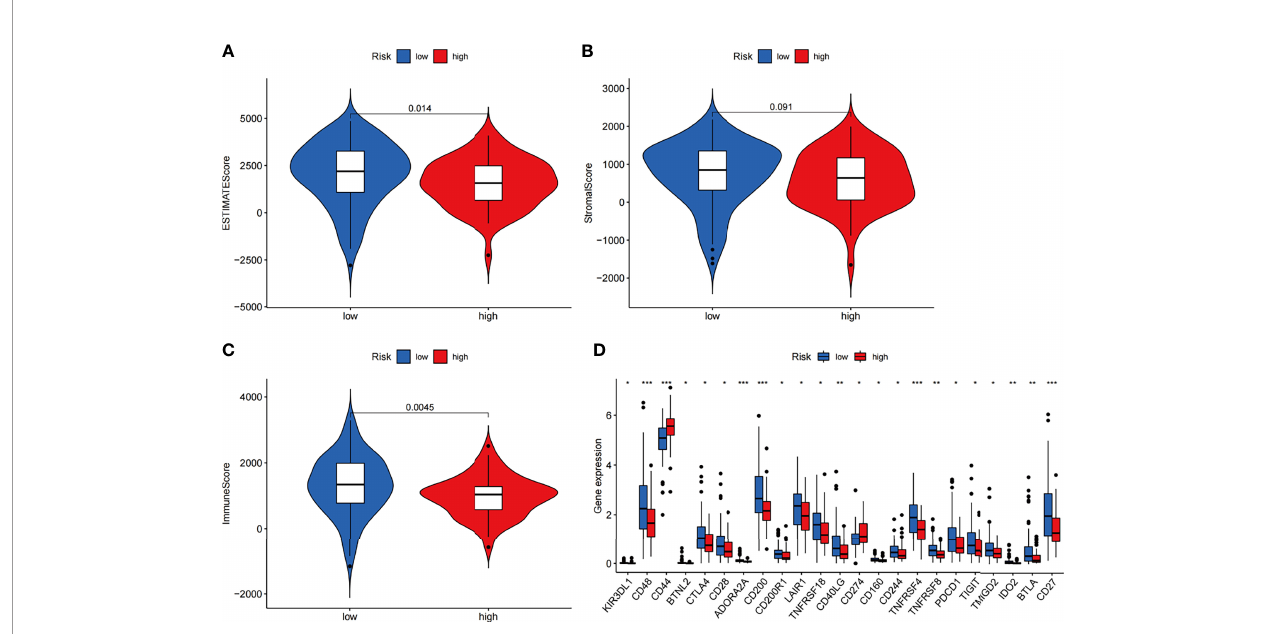
FIGURE 7 | Estimation of immune cell in fi ltration in the two groups of the TCGA-PAAD cohort according to ARGP scores. (A – C) Violin plots of tumor purity for the low- and high-risk groups according to the stromal score (A) , immune score (B) and ESTIMATE score (C) . (D) Comparison of the expression of immune checkpoint genes between the high- and low-risk groups (*p < 0.05, **p < 0.01, and ***p <